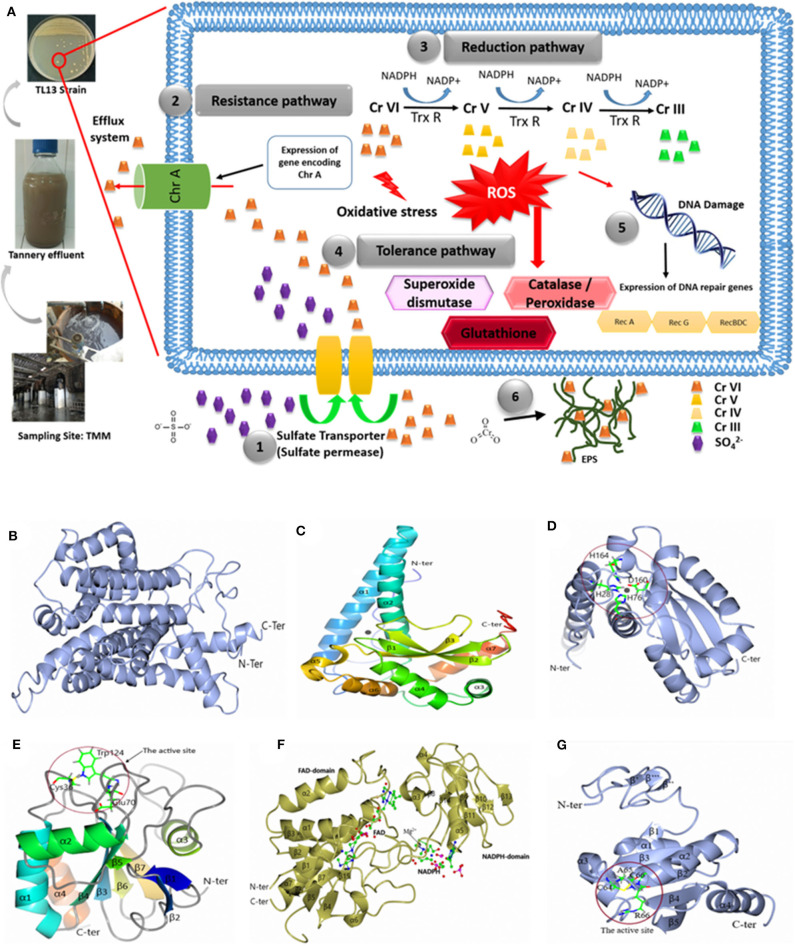
(A) Hypothetical pathways involved in chromium resistance and reduction in M. metallidurans TL13: (1) The sulfate permease allows chromium to get into bacterial cell; (2) expression of gene encoding chromate transporter ChrA (Efflux system); (3) reduction of chromium due to thioredoxin reductase and NADPH; (4) oxidative stress due to chromium reduction [Cr(V) and Cr(IV)] induced reactive oxygen species (ROS): superoxide dismutase, catalase, peroxidase, and glutathione; (5) DNA damage: expression of dna repair genes (RecA, RecG, and RecBDC); and (6) exopolysaccharides (EPS) and metal complex. Cartoon representation of 3D structure of TL13: (B) chromate transporter; (C) superoxide dismutase; (D) the active site of superoxide dismutase; (E) glutathione peroxidase with the localization of the active site; (F) thioredoxin reductase with the localization of reduced nicotinamide adenine dinucleotide phosphate (NADPH) and flavin adenine dinucleotide (FAD) domain, and (G) 3D structure of TL13 thioredoxin with the localization of the active site.